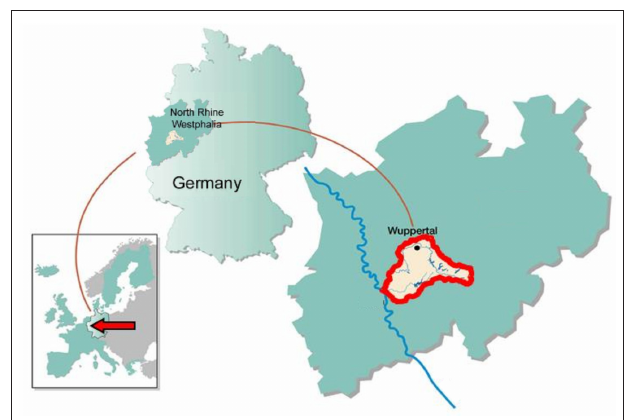
FIGURE 1 | Location of the Wupper catchment in Europe, in western Germany and in the German federal state North Rhine-Westphalia (received from Wupper catchment water board and published as part of the product sheet on https://climate.copernicus.eu/decadal-predictions-infrastructure, modified).